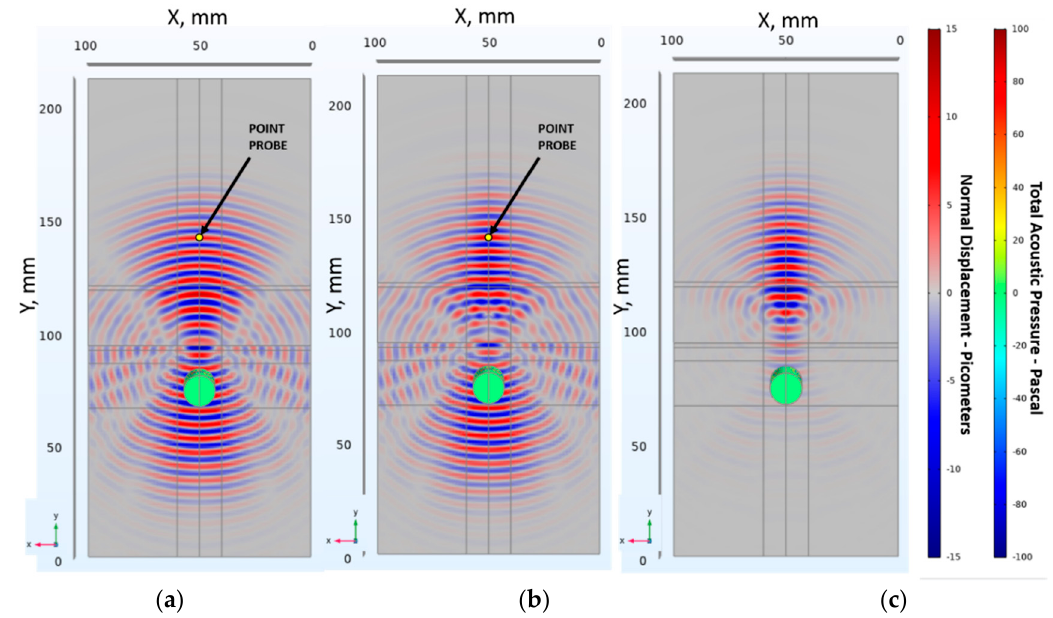
Figure 16. Snapshots from simulation (bottom view) of the mirrored model, which shows the normal distributions at the time instant 75 µs: ( a ) the case with no defect; ( b ) the case with the defect; ( c ) the differential image.